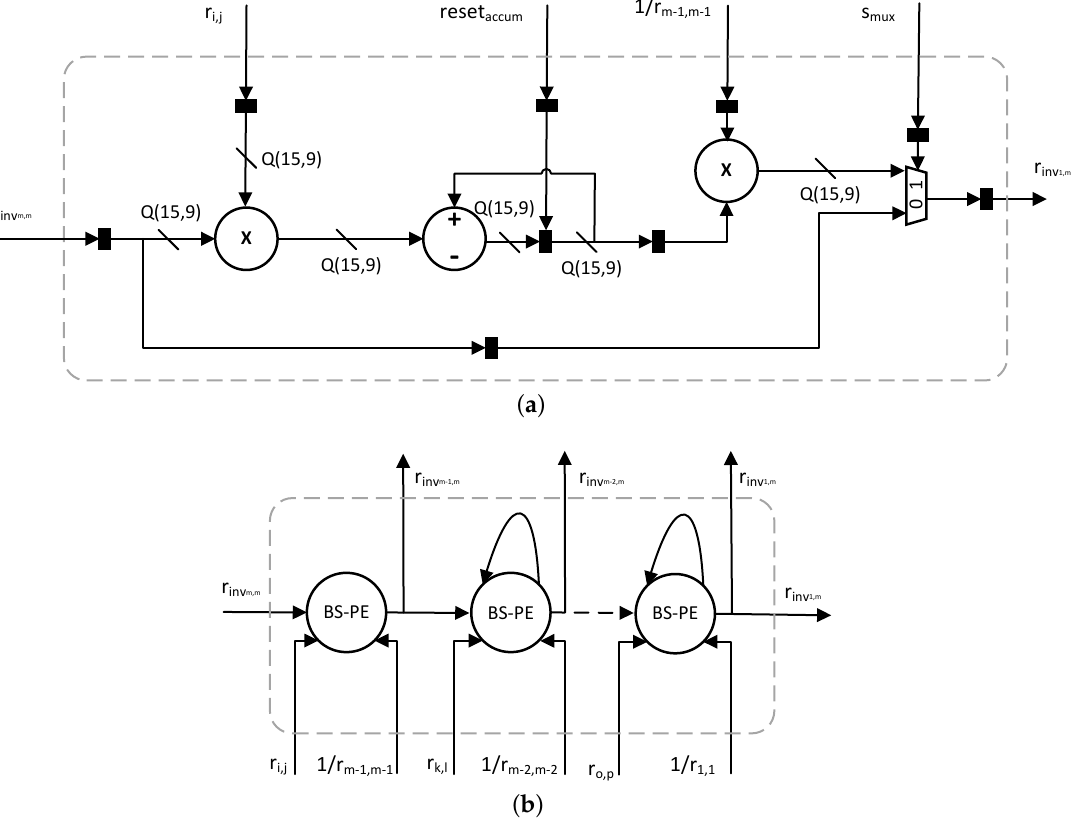
Figure 6. Back substitution architecture: ( a ) General architecture, ( b ) Processor element internal architecture